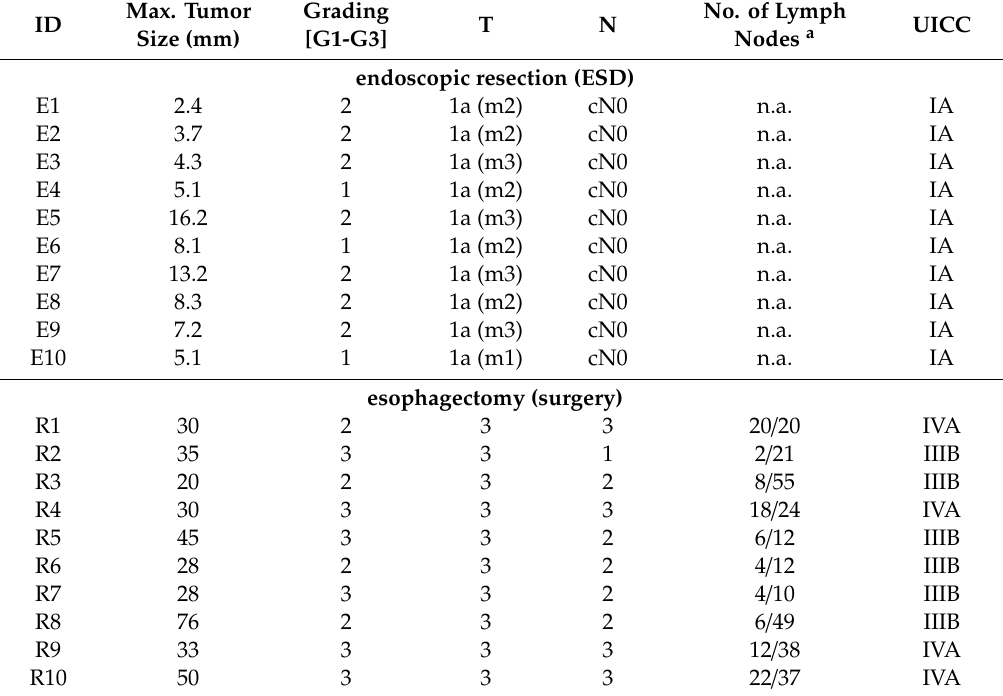
Table 2. Patient characteristics with esophageal adenocarcinomas (EAC) tumor staging according to the 8 th edition of the TNM [30]. All cases were clinically assessed as cM0.